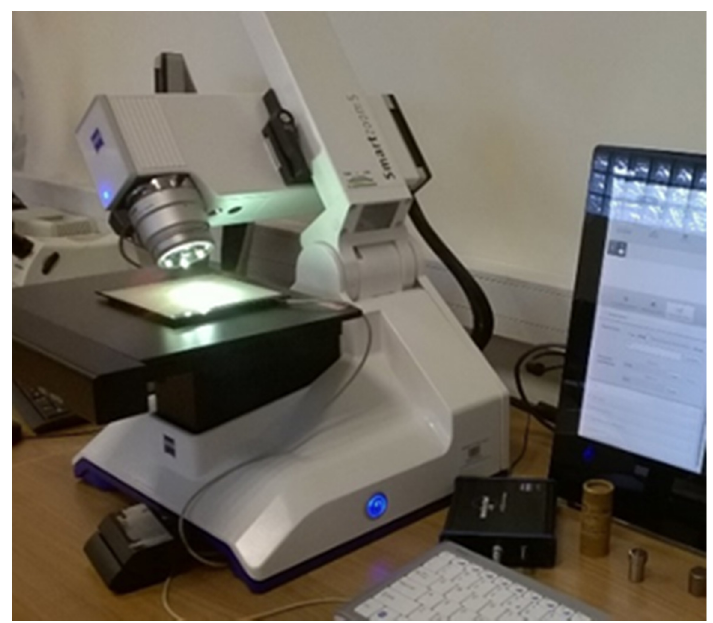
Figure 5. Measuring microscope used for observing wear degree of cutting insert.